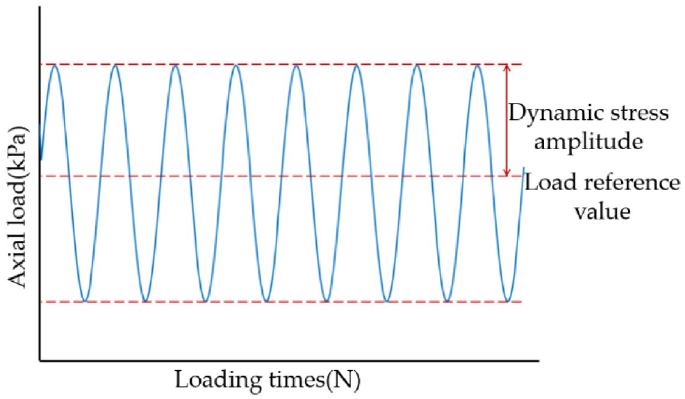
Figure 3. Single-stage cyclic loading diagram-typical sinusoidal cyclic loading.